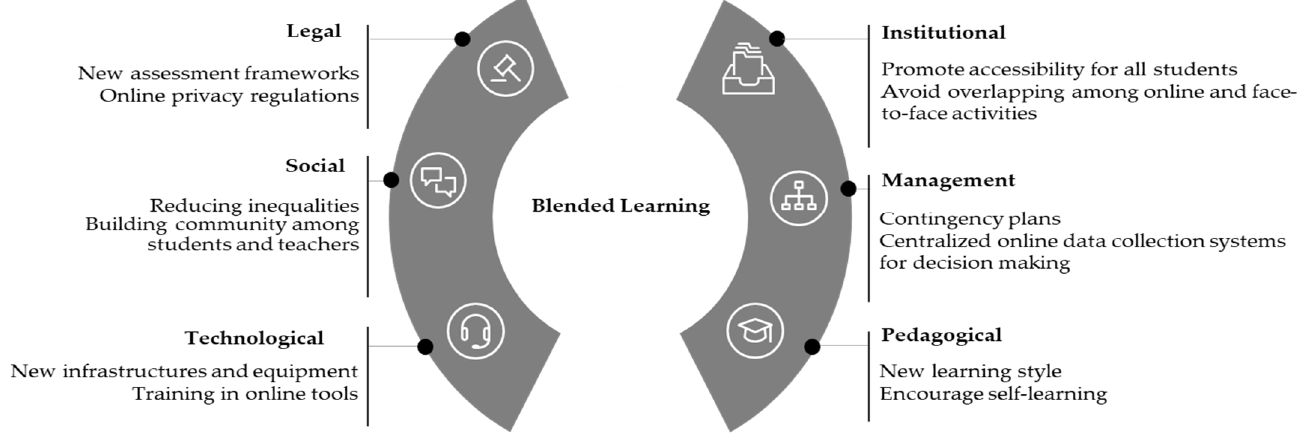
Figure 2. The challenges in and the course of action for implementing blended learning based on the COVID-19 experience.